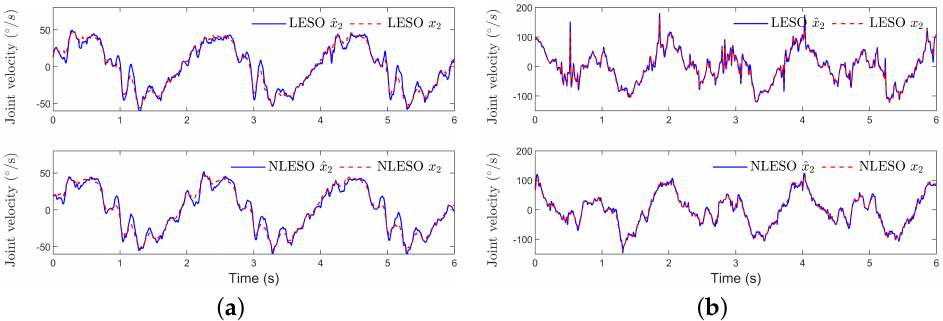
Figure 4. The state variable x 2 and its estimation ˆ x 2 from the LESO (upper subfigure) and NLESO (lower subfigure) observers for the hip ( a ) and knee ( b ) joints.